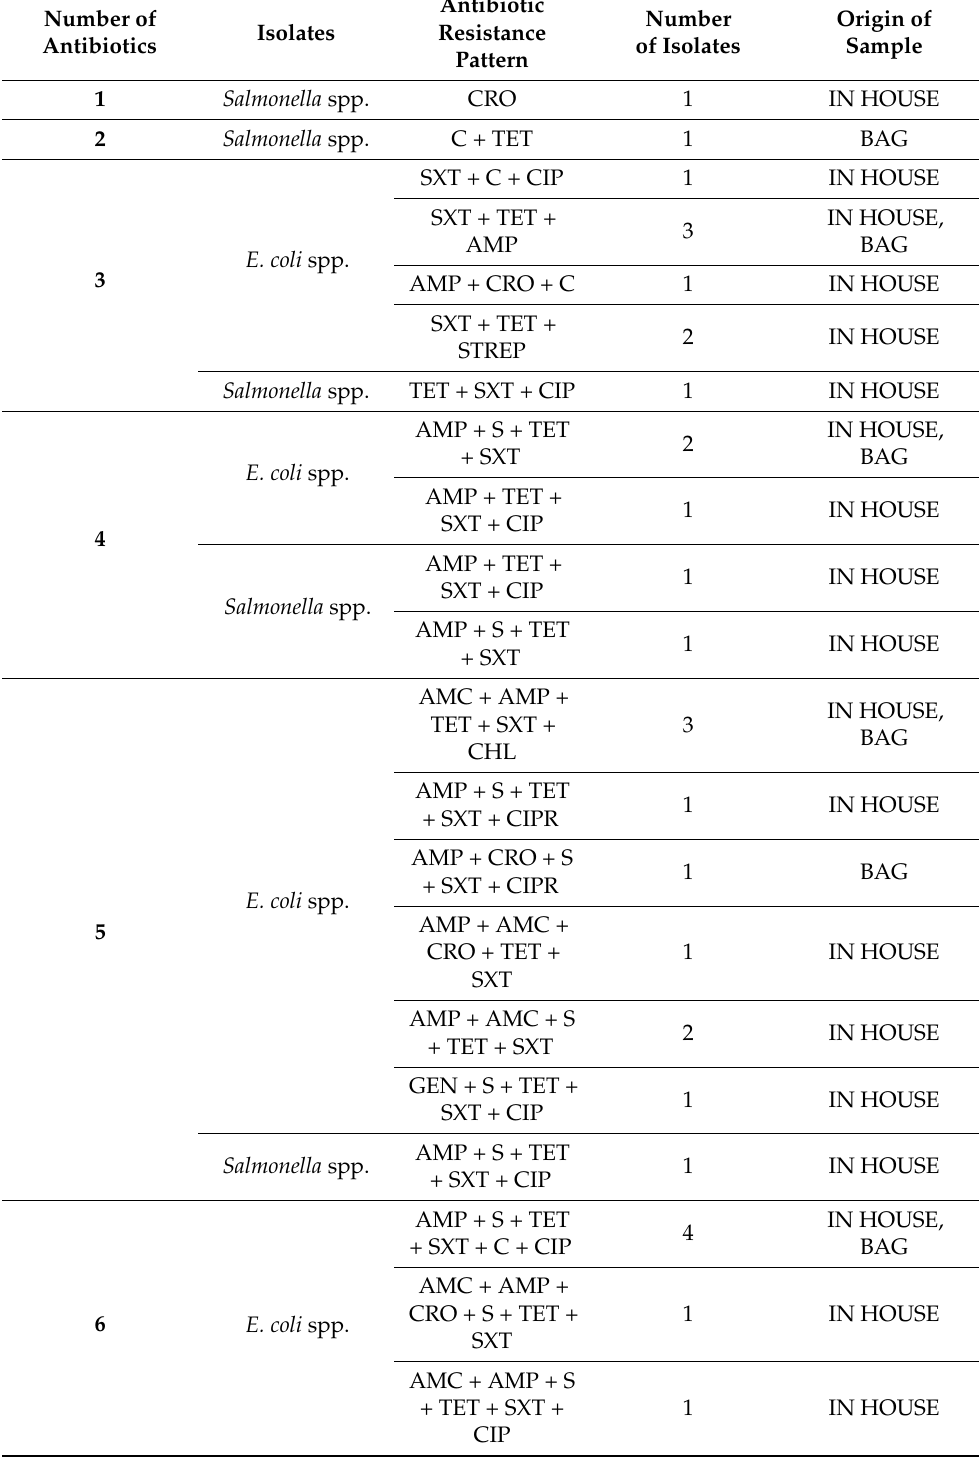
Table 3. Co resistance patterns of E. coli and Salmonella spp.